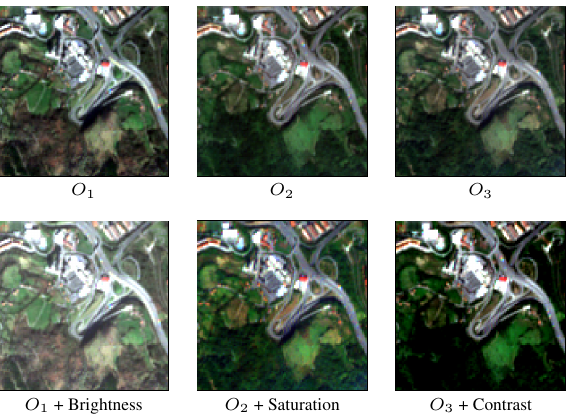
Figure 1. Visual comparison of the proposed multi-temporal color DA technique based on multiple observations and the corresponding altered versions using standard photometric